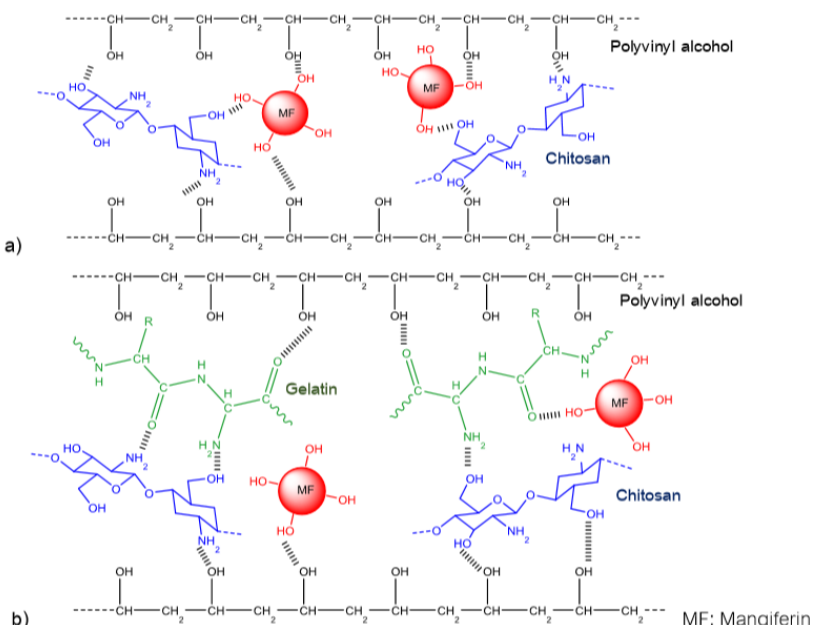
Figure 2. The proposed schematic illustration of inter-molecular and intra-molecular hydrogen bonding in the mangiferin loaded hydrogels: ( a ) binary blend and ( b ) ternary blend [151]. Mangiferin is capable of hydrogen bonding with the amide and hydroxyl pendent groups in the homopolymer matrices. Among them, as a polyphenolic, mangiferin prefers to form strong inter-molecular hydrogen bonding between hydroxyl groups and amide and hydroxyl pendent groups of chitosan rather than with PVA’s hydroxyl groups. Gela- tin molecules consisting of a multitude of branching and heterocyclic bulk groups increase volume and decrease the strength of hydrogen bonds in hydrogels. Thus, increasing the